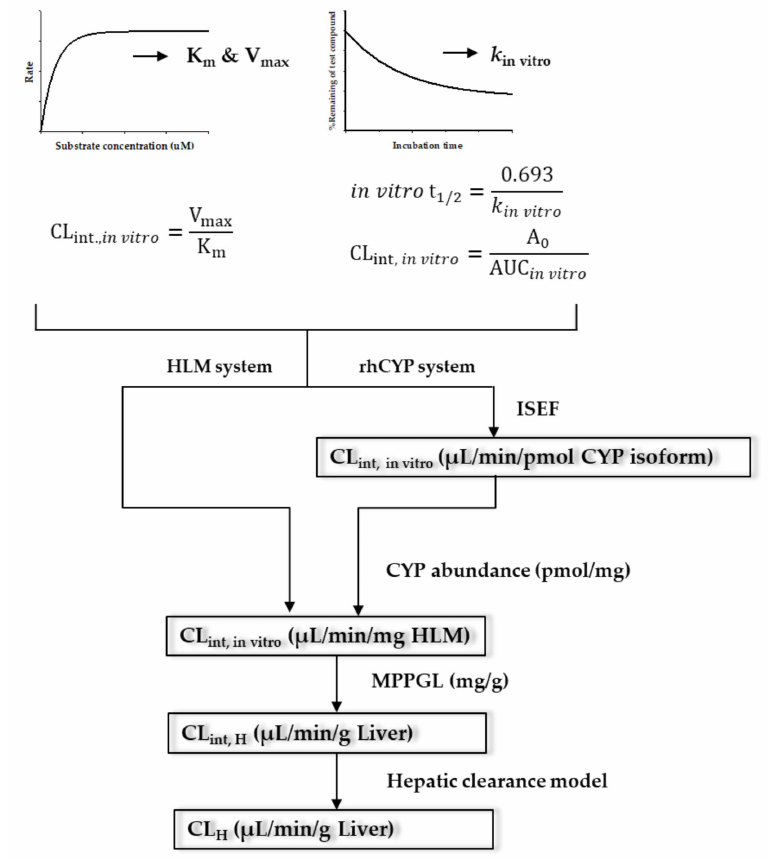
Figure 2. The scheme of the overall in vitro-in vivo extrapolation (IVIVE) process using human liver microsomes or recombinant human cytochrome P450 (CYP) system. MPPGL refers to the microsomal protein per gram of